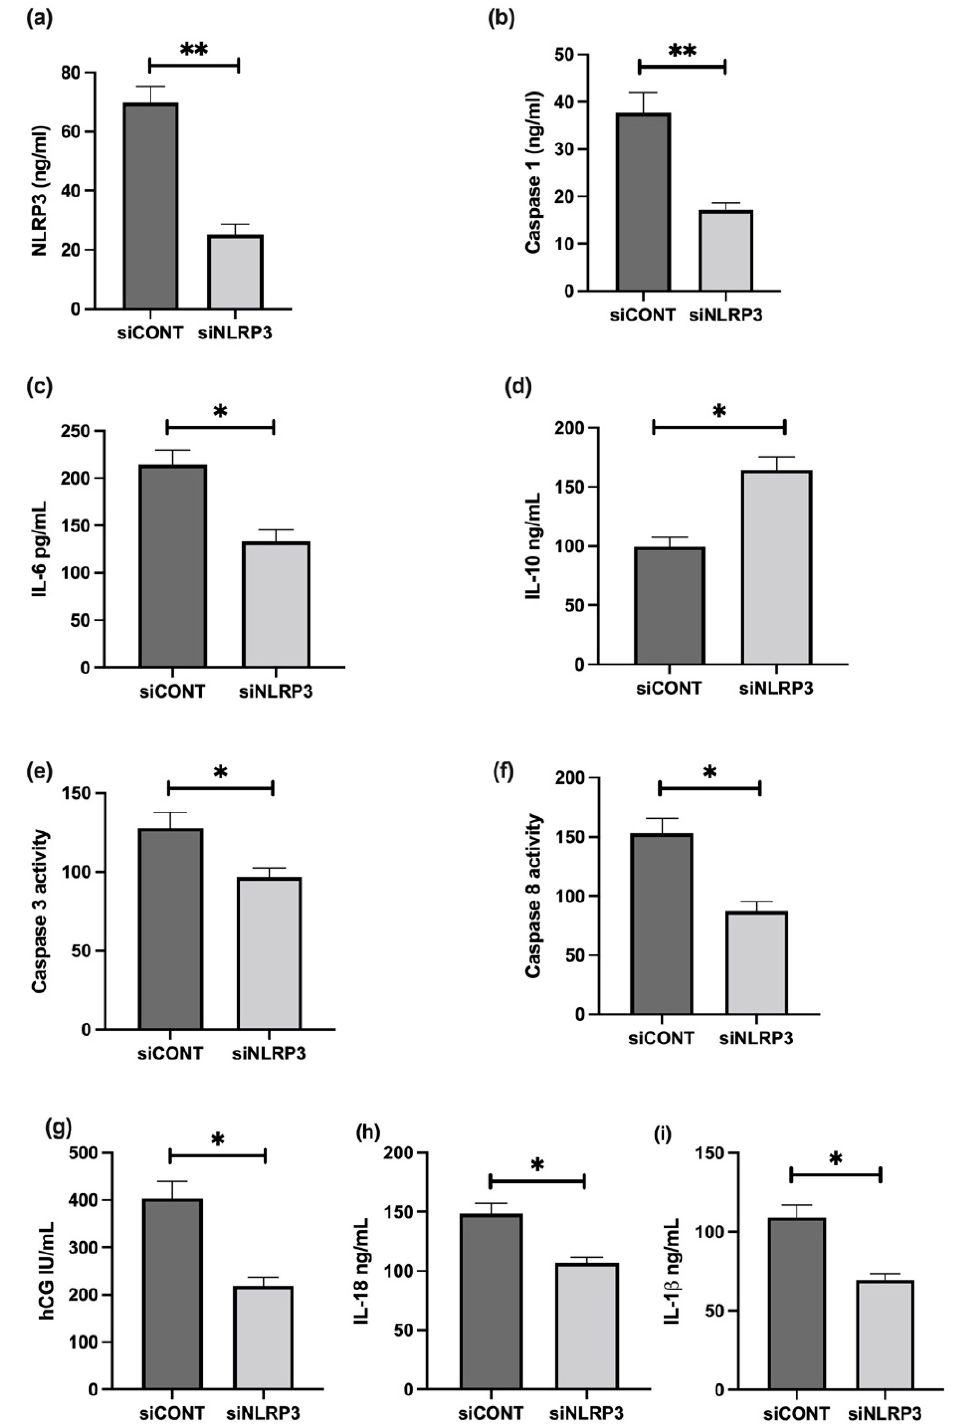
Figure 10. Effect of NLRP3 siRNA inactivation and LPS on protein expression of NLRP3, caspase-1, pro- and anti-inflammatory cytokines, trophoblast differentiation marker, and activity of apoptosis markers in BeWo cells. Protein concentrations of ( a ) NLRP3, ( b ) caspase-1, ( c ) IL-6, ( i ) IL-1 β , ( h ) IL-18, ( g ) β hCG, and ( e ) caspase-3 and ( f ) caspase- 8 activities significantly decrease in siNLRP3 treated cells compared to siCONT treated cells. In contrast, ( d ) IL-10 protein concentrations significantly increase in siNLRP3 + LPS treated BeWo cells, compared to siCONT treated cells. Significant differences are denoted by * p < 0.05; ** p < 0.005.